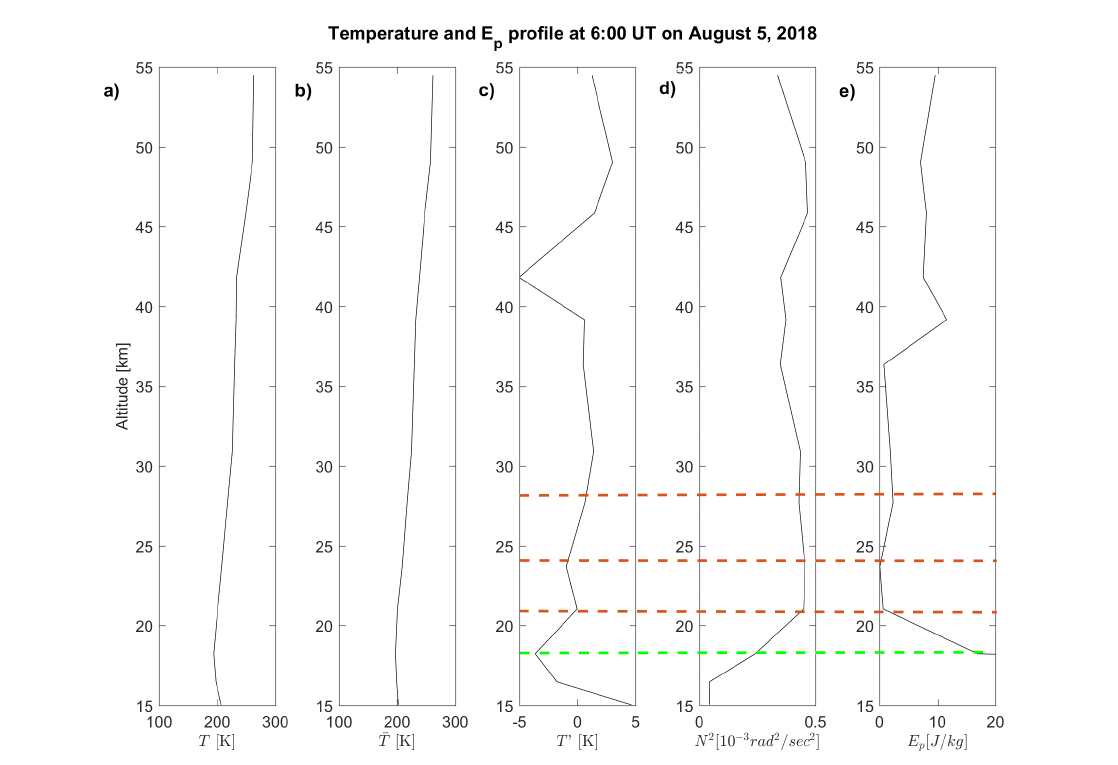
Figure 5. Pre-seismic vertical profiles of: ( a ) temperature; ( b ) background temperature; ( c ) temperature deviation; ( d ) square term of Brunt-V¨ ais ¨ al ¨ a frequency; ( e ) potential energy 6:00 UT on 5 August 2018. Red horizontal dashed lines represent the AGW peaks identified; the green horizontal dashed line identify the tropopause